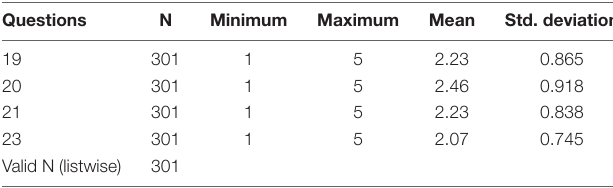
TABLE 5 | Descriptive statistics of the questions related the engagement of technology-integrated classrooms.